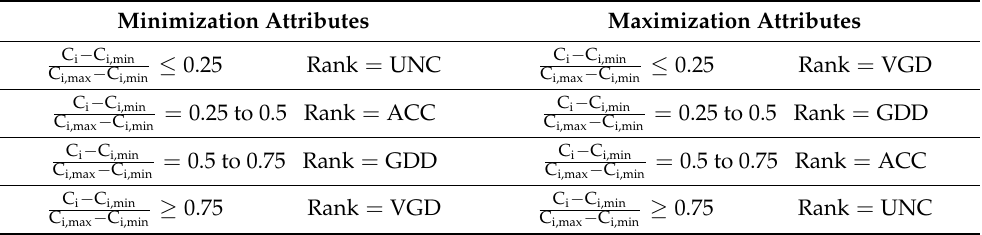
Table 2. Rules for ranking the attributes.